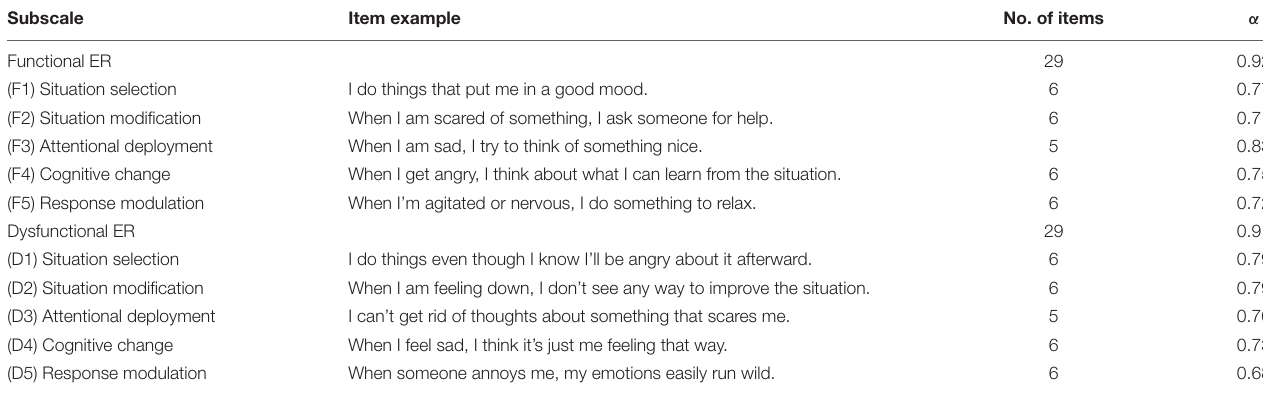
TABLE 1 | Item examples, number of items, and internal consistencies (Cronbach’s α ) of the POEM-CA primary and secondary subscales. Subscale Item